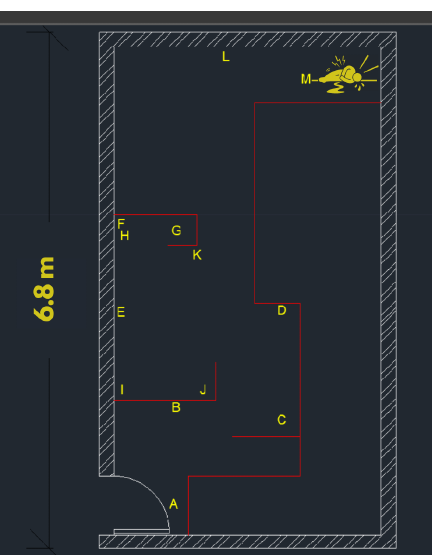
Figure 8. The room we used for